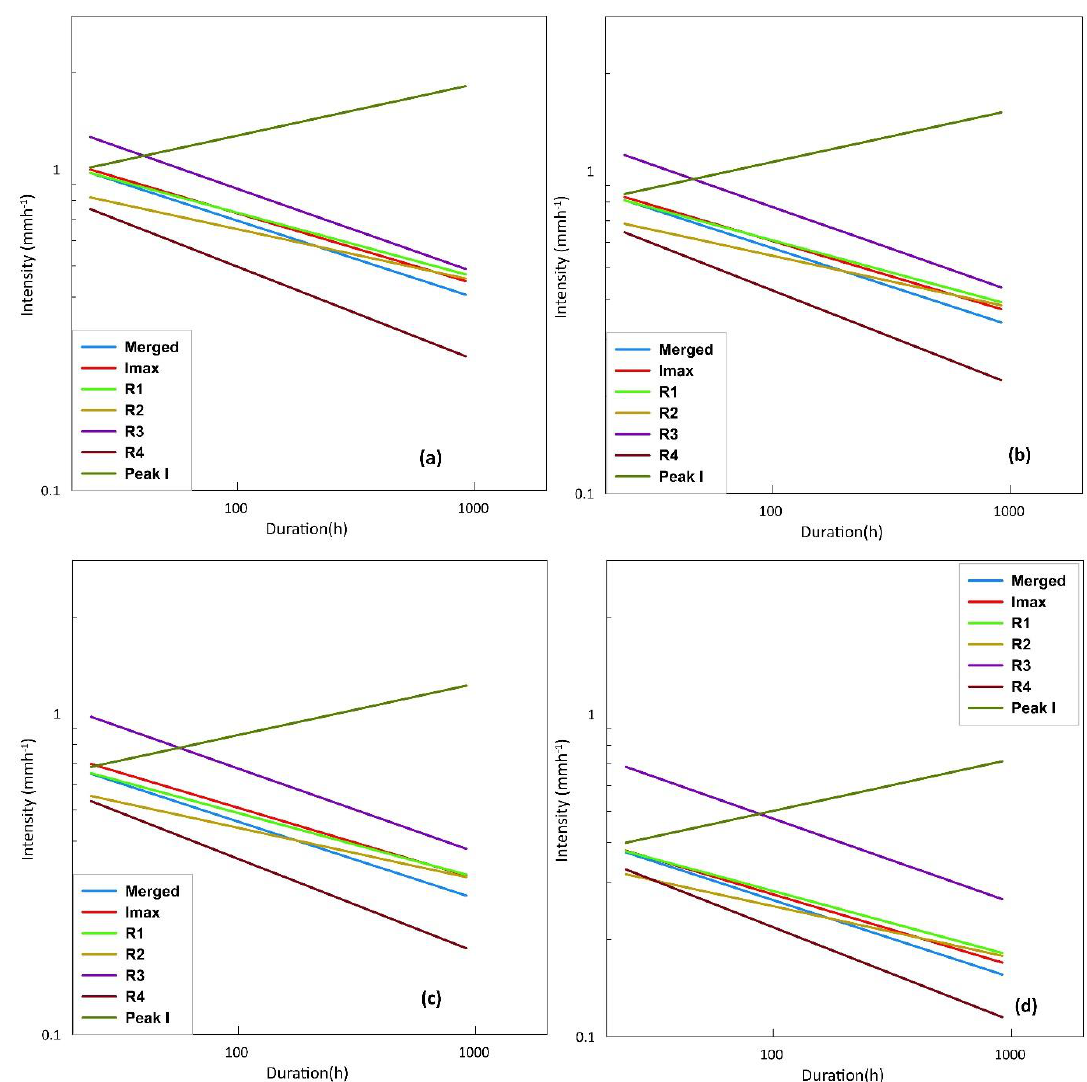
Figure 10. Comparison of different thresholds at ( a ) 5% exceedance probability ( b ) 2.5% exceedance probability ( c ) 1% exceedance probability ( d ) 0.05% exceedance probability.